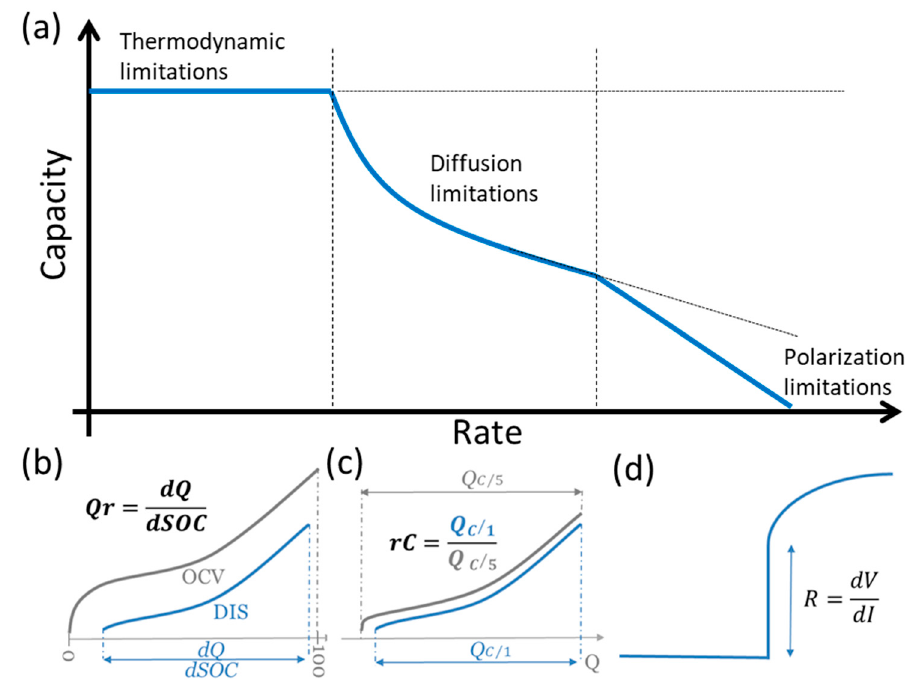
Figure 3. ( a ) Capacity vs. rate relationship and ( b – d ) the three attributes that quantify cell-to-cell variations.